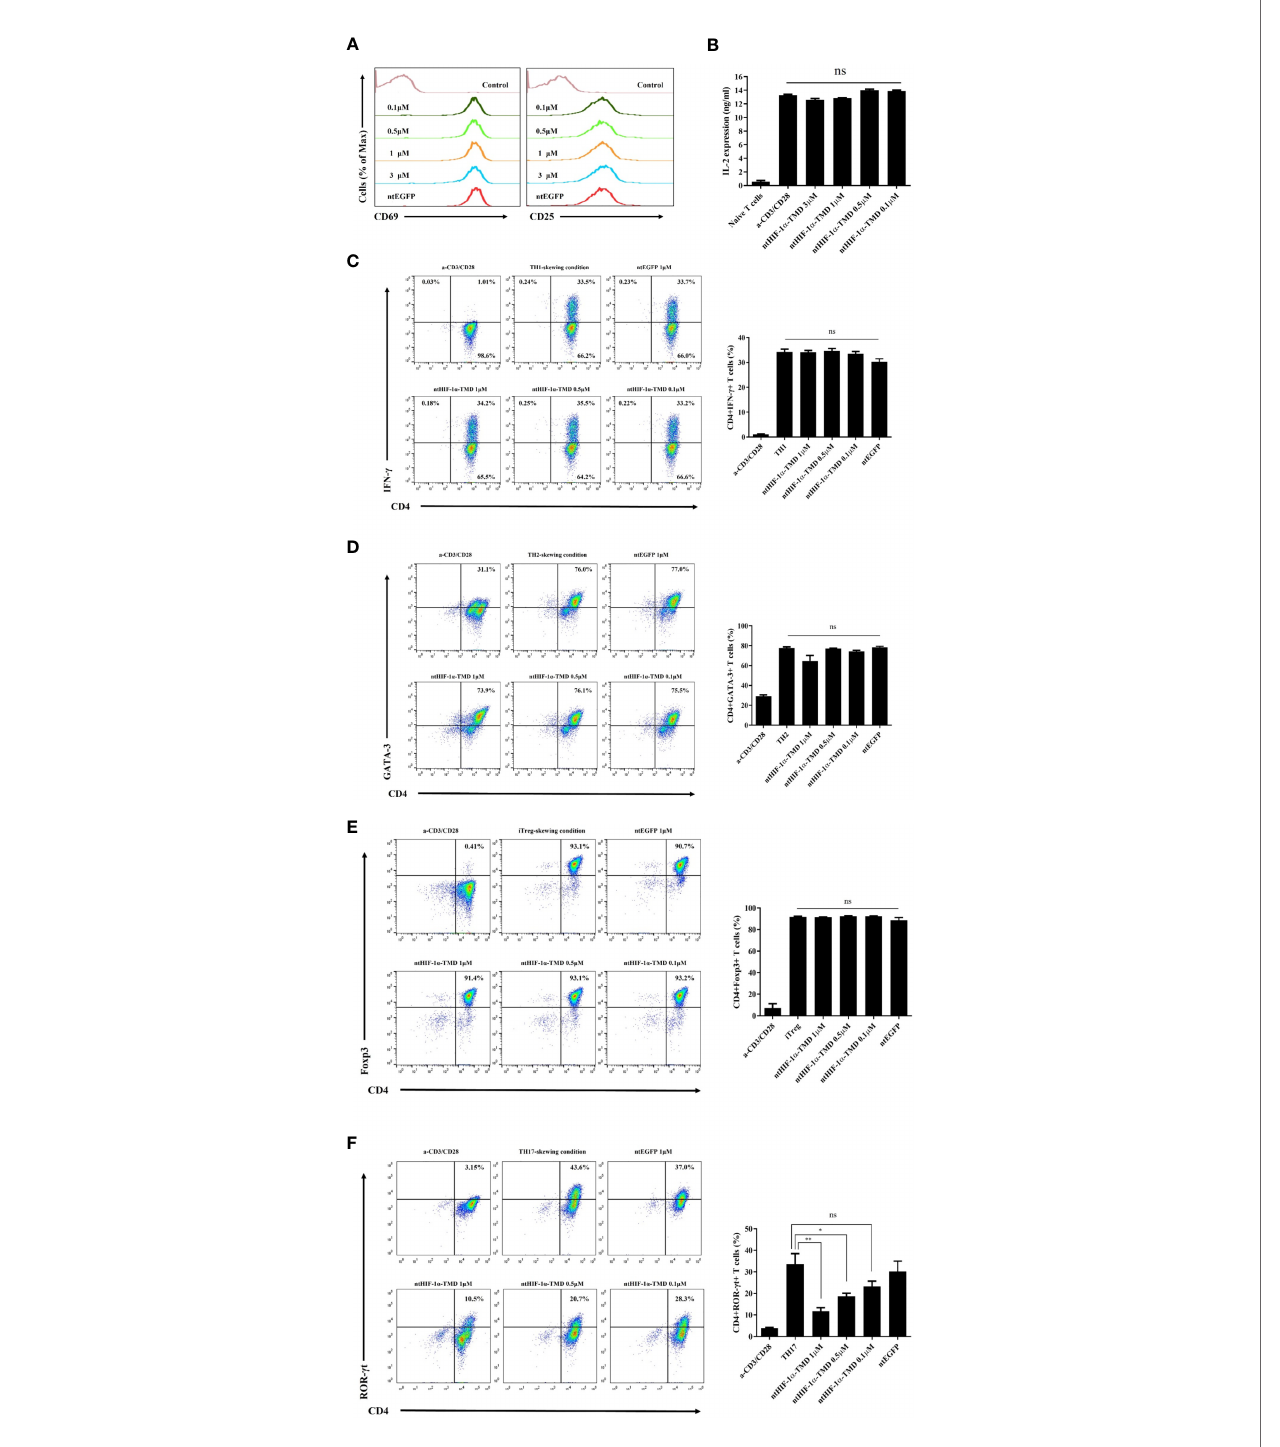
FIGURE 1 | Examination of the functional in fl uence of ntHIF-1 a -TMD on CD4+ T-cell subsets. (A) The induced expression of the surface proteins associated with T-cell activation was analyzed by fl ow cytometry on CD4+ T cells activated by anti-CD3 ϵ and anti-CD28 with or without ntHIF-1 a -TMD treatment. Hph-1-PTD-fused enhanced green fl uorescent protein (ntEGFP) was used as a negative control. (B) The secreted IL-2 in the supernatant from the cells in (A) was measured by ELISA. (C – F) The functional in fl uence of ntHIF-1 a -TMD on TH1, TH2, iTreg, or TH17 cells was evaluated by fl ow cytometry after 72 h incubation in the T-cell subset- skewing condition with ntHIF-1 a -TMD. All experiments shown here were repeated three times. Data are represented as mean ± SEM ( n ≥ 3), and the statistical analysis was examined using Student ’ s t -test. ns, not signi fi cant, *P < 0.05, **P <